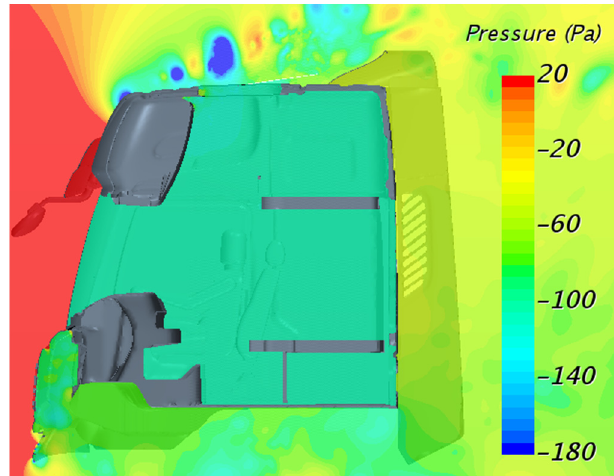
Figure 10. The pressure contour curve of the cab at 60 km/h.